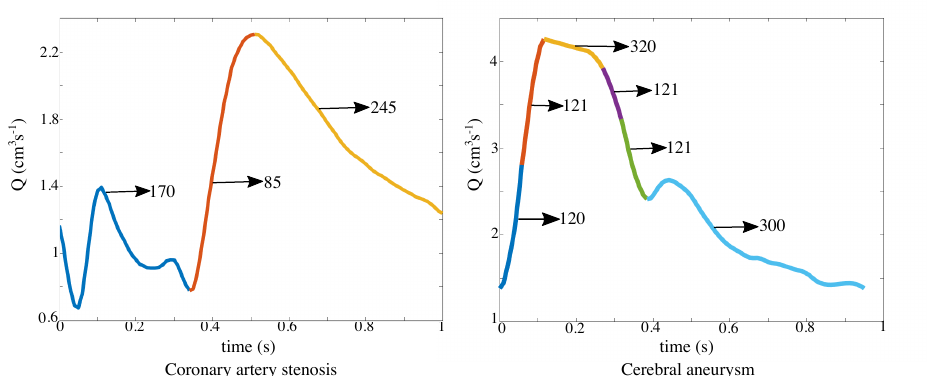
Figure 2. The flow waveform divided into different stages is shown for the coronary artery stenosis and cerebral aneurysm model. Each stage is colored differently and the number of snapshots used are shown next to the arrow. The coronary artery flow rate is divided into three stages: low flow rate, flow acceleration, and flow deceleration. The aneurysm’s flow is divided into six stages based on the shape of the waveform: two stages during flow acceleration, three stages during flow deceleration, and one stage during low flow rate in